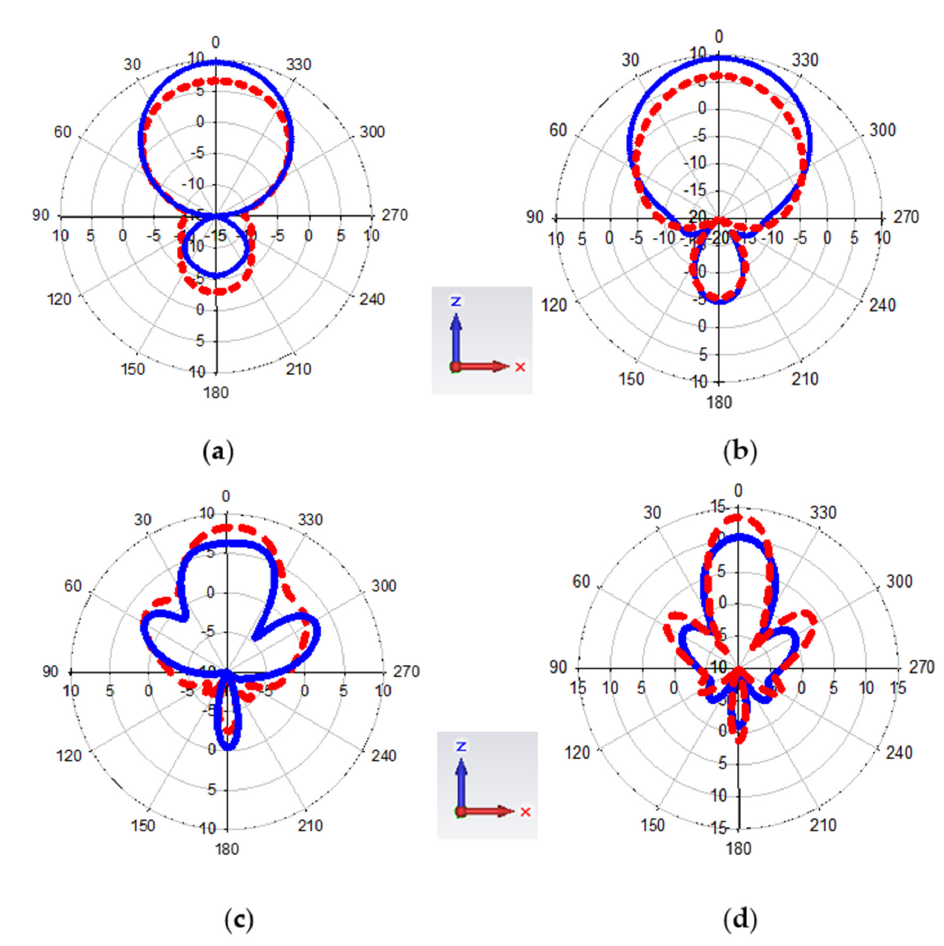
Figure 13. E-plane radiation pattern in red colour (simulated) and blue colour (measured) for ( a ) 3 GHz, ( b ) 4 GHz, ( c ) 5 GHz, ( d ) 6